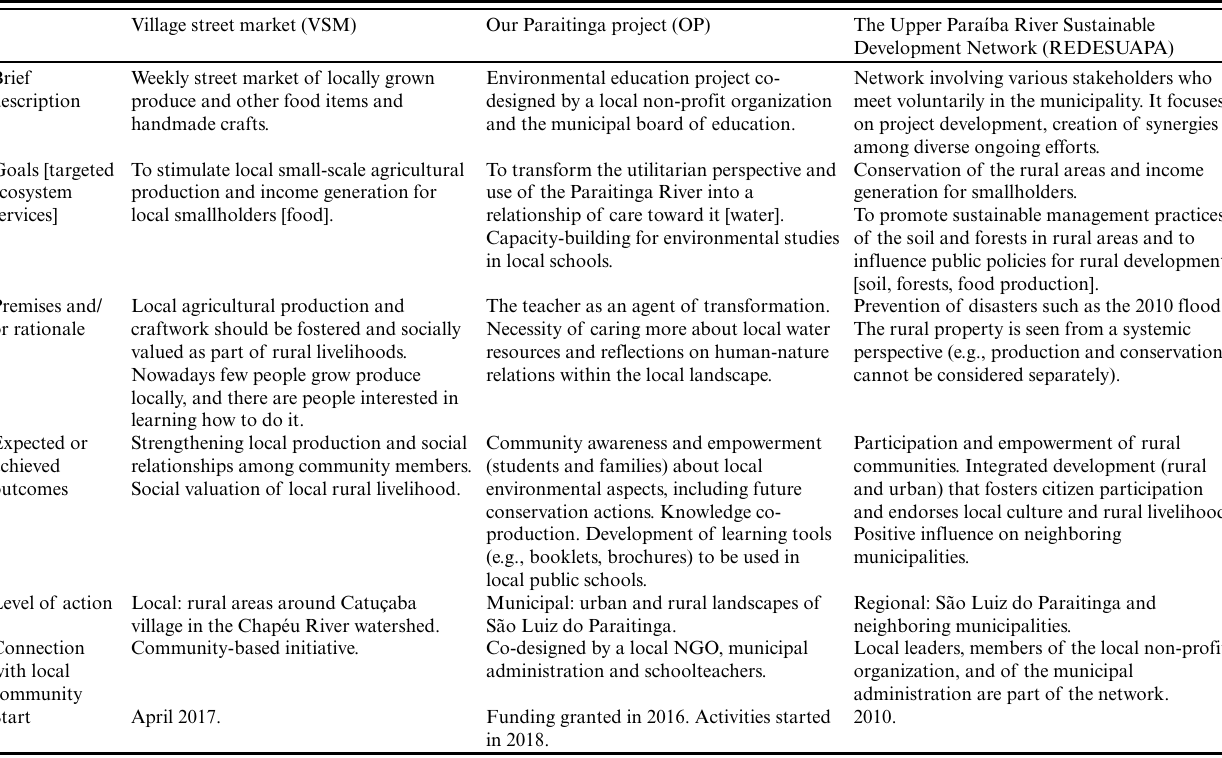
Table 2 . Main aspects of three environmental initiatives impacting critical ecosystem services (i.e., water, food, soil, forests) in the Chapéu River watershed, São Luiz do Paraitinga municipality, southeast Brazil. Village street market (VSM) Our Paraitinga project (OP) The Upper Paraíba River Sustainable Development Network